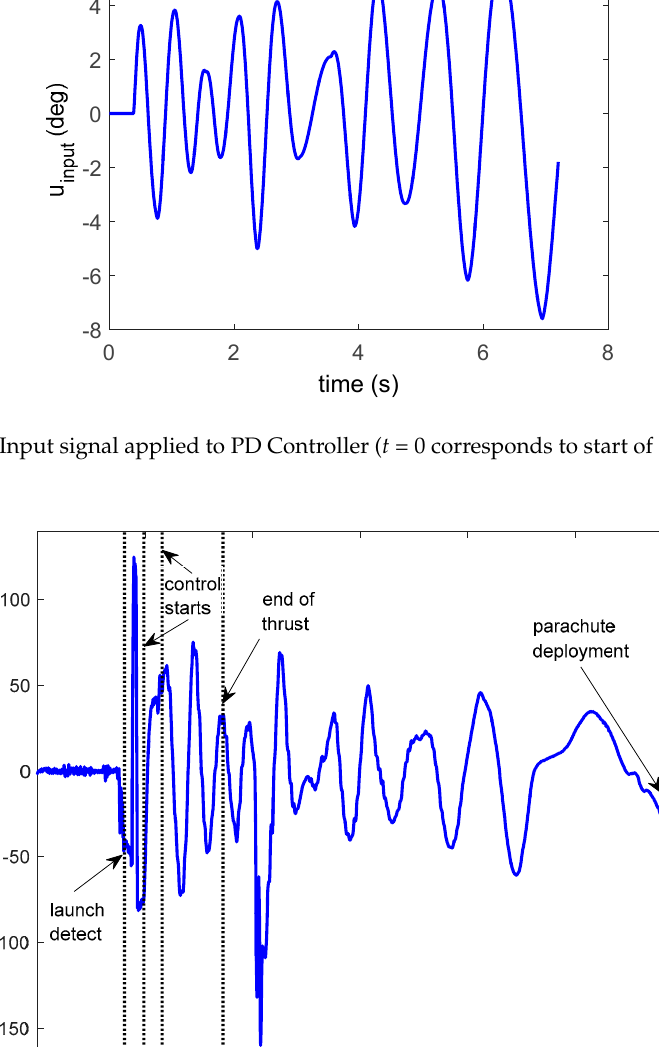
Figure 27. Roll rate response for Tasha III launch 2 including key points in the launch.